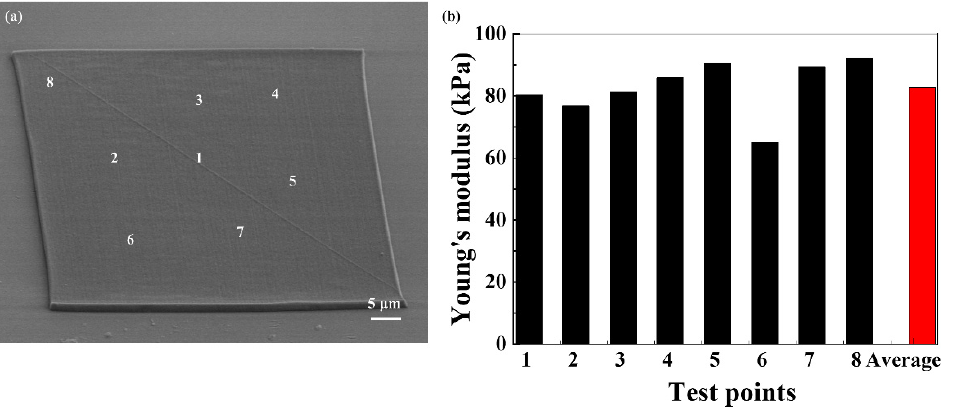
Figure 3. ( a ) SEM image of cubic microstructure. ( b ) The corresponding Young’s modulus of different location measured by AFM.